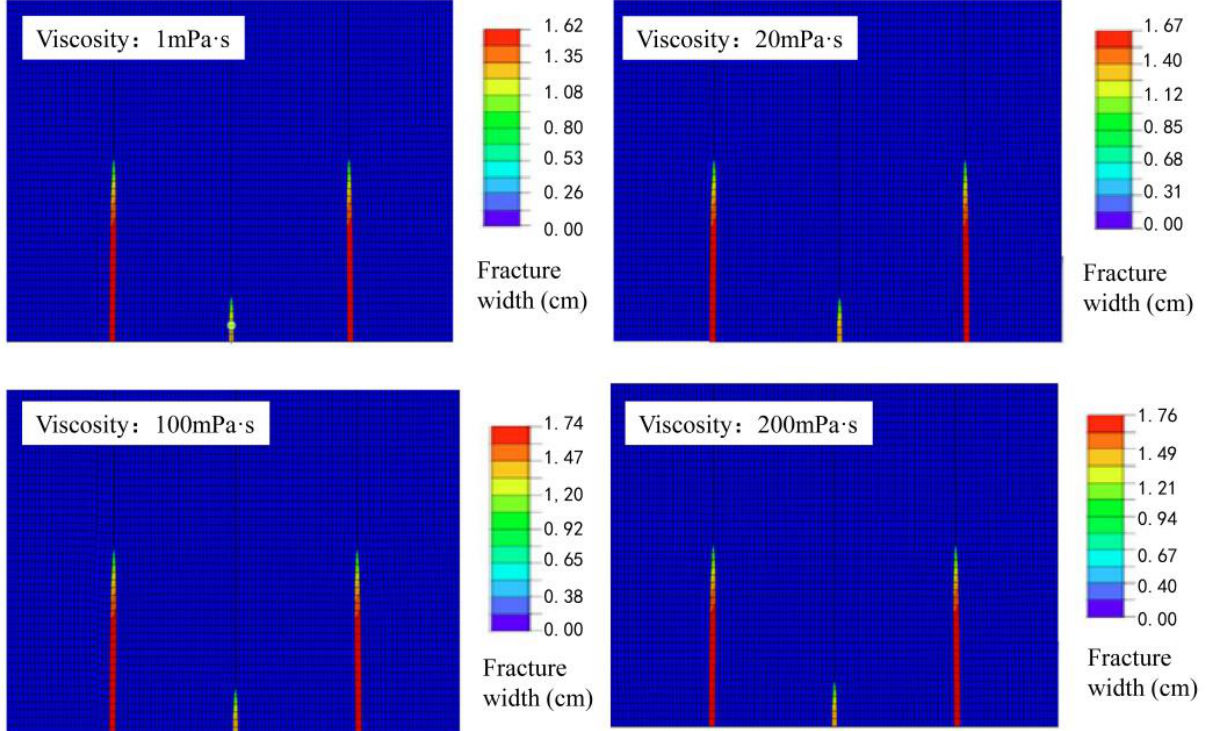
Figure 9: Result of fracture morphology after fracturing for 10 minutes by using fracturing fluid with different viscosities. (Deformation scale factor = 500, 30 cluster spacing).